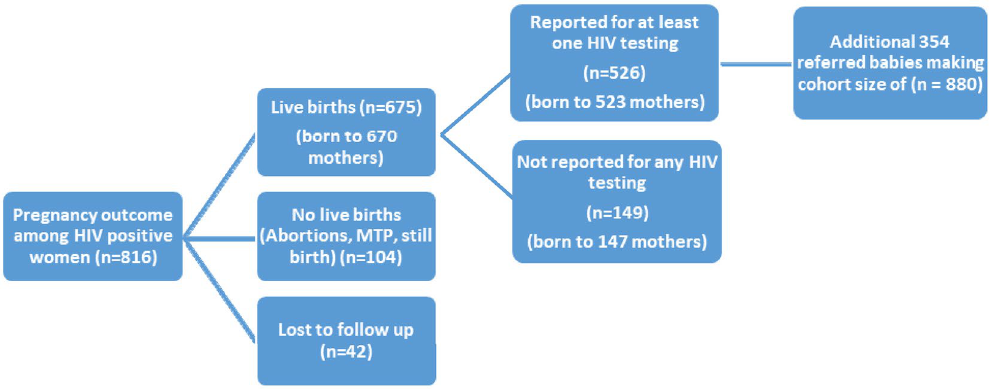
Figure 2. Pregnancy Outcomes and Access to HIV testing among infants born to mothers with HIV at the selected ICTCs (2016–2017) (n =